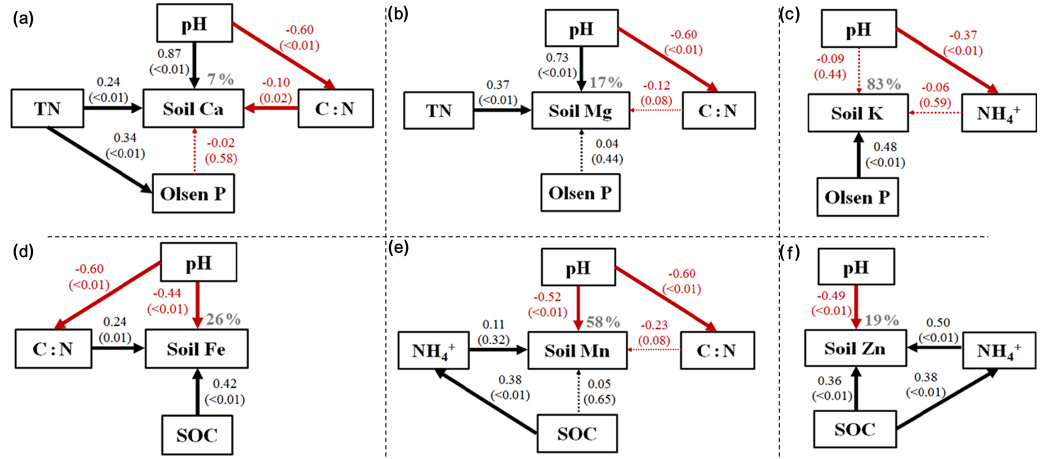
Figure 5. The results of structural equation modeling of the effect of soil parameters on soil exchangeable base cations of Ca, Mg, and K, and available micronutrients of Fe, Mn, and Cu. Arrows indicate positive (black) and negative (red) effects. Solid and dotted lines represent significant and non-significant relationships, respectively. The number adjacent to each arrow is the standardized path coefficient with corresponding p value in